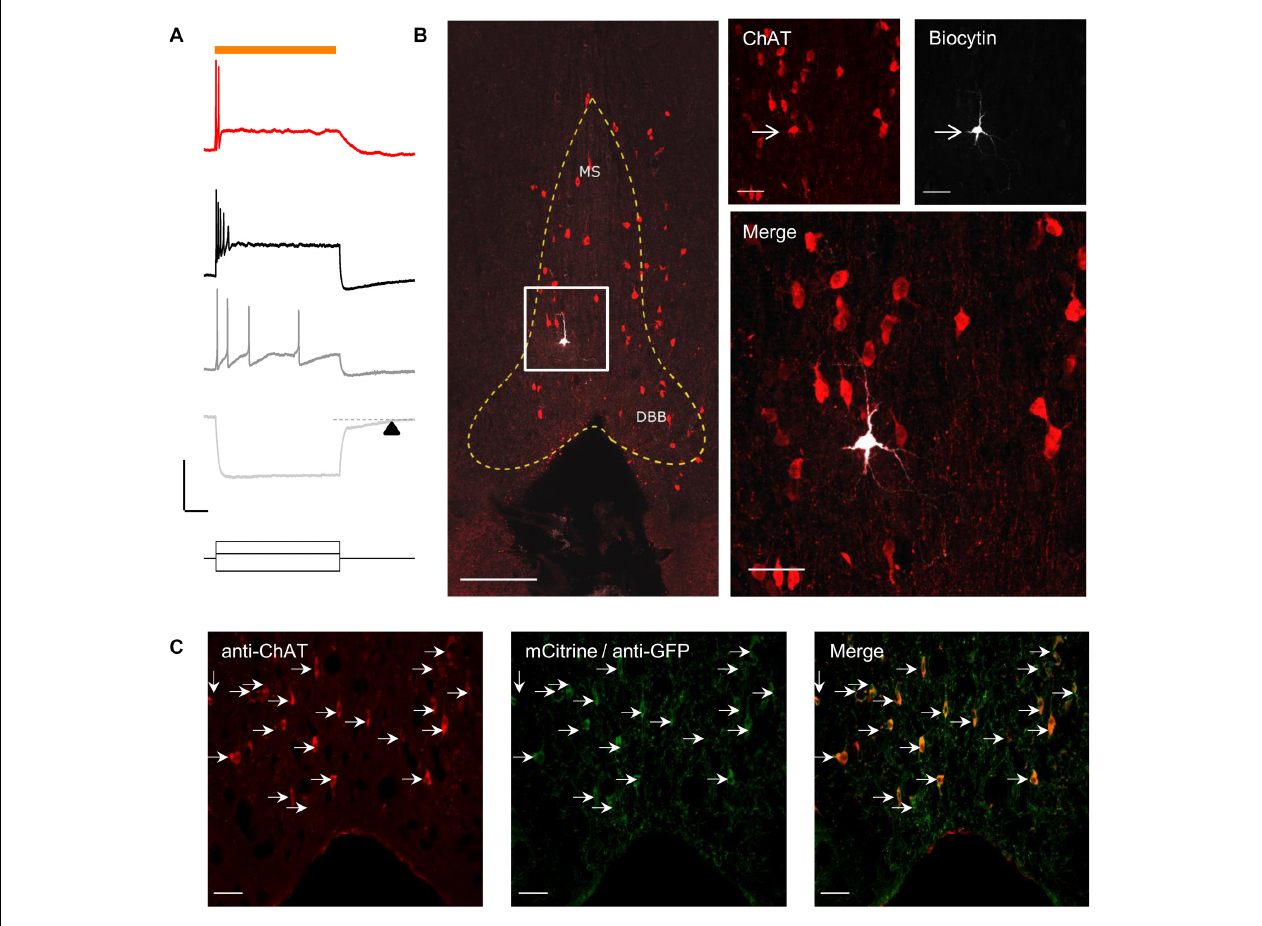
FIGURE 1 | Red-shifted optogenetic protein (ReachR) was functionally expressed in MS/DBB cholinergic neurons and terminals of Chat-cre × ReaChR-mCitrine mice. (A) Upper, Representative trace (red) showing a MS/DBB cholinergic neuron that depolarized and fired action potentials (APs) in response to a 600 ms long pulse of yellow light (indicated by orange bar); Lower, The membrane potential changes in the same cell in response to injection of –200 pA (light gray), + 75 pA (dark gray), and + 275 pA (black) current steps. The time delay in returning to baseline (dashed line) following hyperpolarization in response to a negative current injection is indicated by the black triangle; Scale bars: x = 200 ms and y = 20 mV. (B) Left, Image of the MS/DBB in a coronal brain slice: anti-choline acetyl transferase (ChAT, red); biocytin filled cell (white) from (A) ; scale bar = 100 µ m. The MS/DBB area is marked by yellow dashed lines. Right, magnified z -projection image of the same region (indicated by white box in left) showing the biocytin filled cell was positive for ChAT (red); scale bar = 50 µ m. (C) Immunofluorescence performed on 50 µ m coronal sections of the MS/DBB showed that ChAT positive neurons (red), indicated by white arrows, were also positive for mCitrine expression (green), and vice-versa; Scale bar = 50 µ